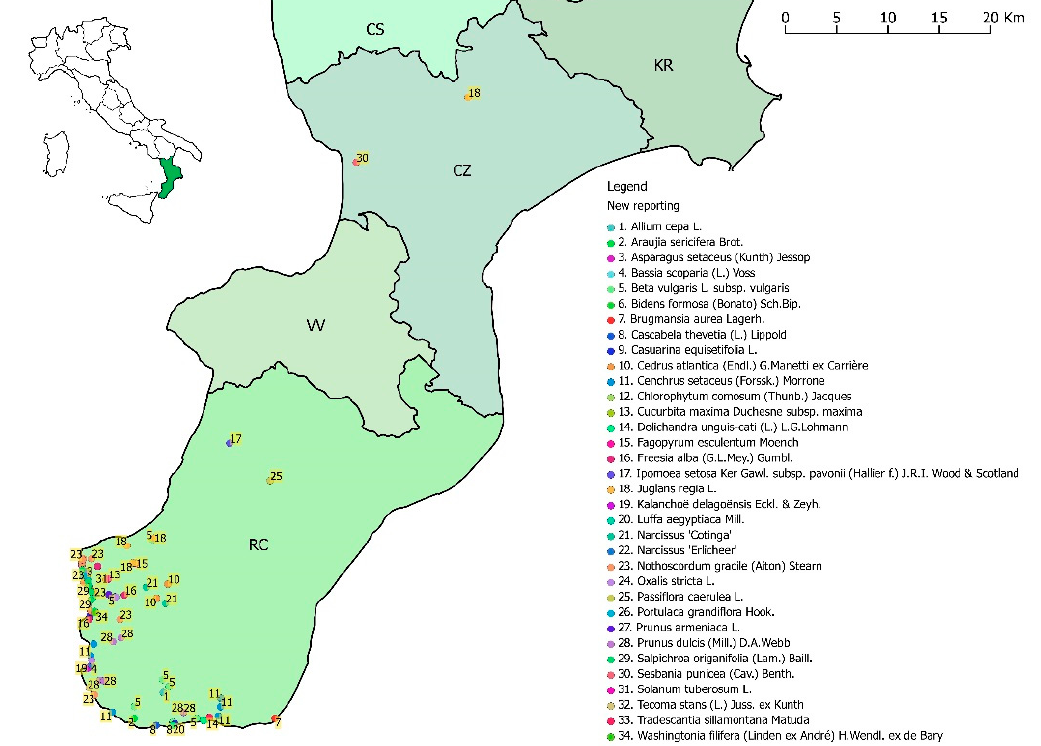
Figure 1. Distribution of the 34 alien taxa recorded for the flora of Calabria (Southern Italy, Europe). Calabrian provinces: CS = Cosenza, CZ = Catanzaro, KR = Crotone, RC = Reggio Calabria, VV = Vibo Valentia.